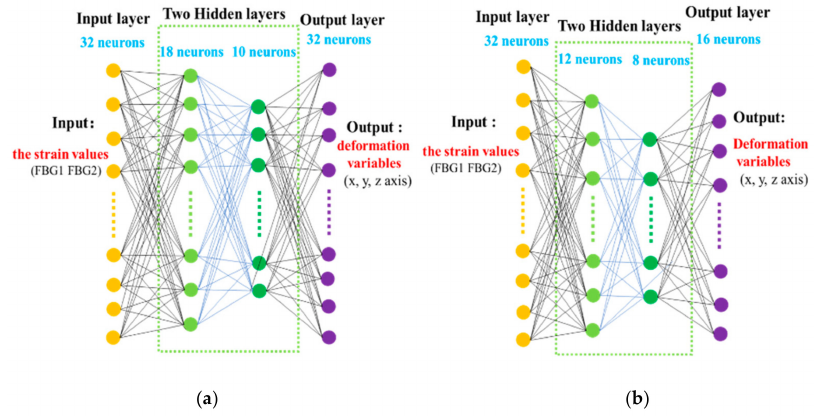
Figure 8. Schematic of the neural network model: ( a ) Model of the x- and y-axis; ( b ) Model of the z-axis.